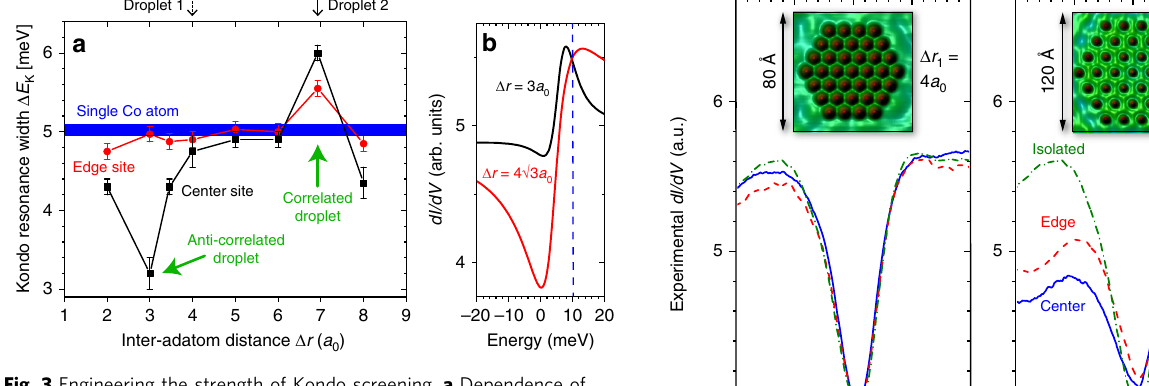
ð r Þ has been K ð r Þ for an K Δ r ¼ 3 a 0 Fig. 4 Observation of enhanced Kondo screening. a Experimental d I = d V spectra measured for the Kondo droplets shown in the insets with lattice spacings a Δ r 1 ¼ 4 a 0 (cid:4) 10 : 2 Å (droplet 1), and b Δ r 2 ¼ 4 (droplet 2) built on the Cu(111) close-packed surface with an exact 6-fold symmetry. Topographic data in insets uses same colorbar as Fig. 1. c , d Theoretical d I = d V lineshapes for the Kondo droplets shown in the insets of a , b , respectively. Note that the experimental data show a weak scattering peak centered at V 0 ¼ (cid:2) 10 mV for droplet 1, and V 0 ¼ (cid:2) 8 mV for droplet 2, which arises from the presence of proximal step edges, and is not directly related to the Kondo resonance. A detailed discussion of how the theoretical lineshapes are obtained is provided in Supplementary Note